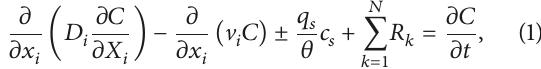
stress periods, respectively, throughout the model stress periods for model calibration. The recharge package was used to simulate spatial distribution of recharge water at field from rainfall and irrigation to the groundwater